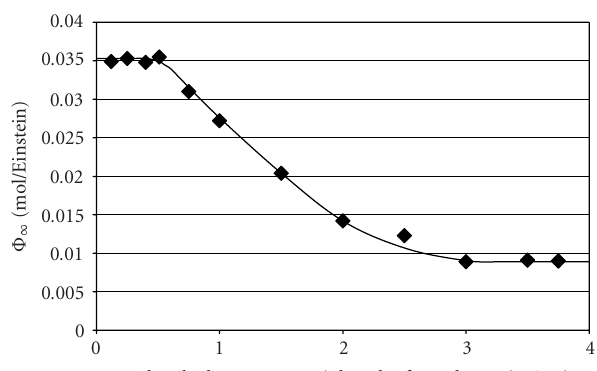
Figure 3: Quantum e ffi ciencies Φ ∞ (mol/Einstein), extrapolated by length of irradiated photocatalytic membrane expressed as Wcm − 1